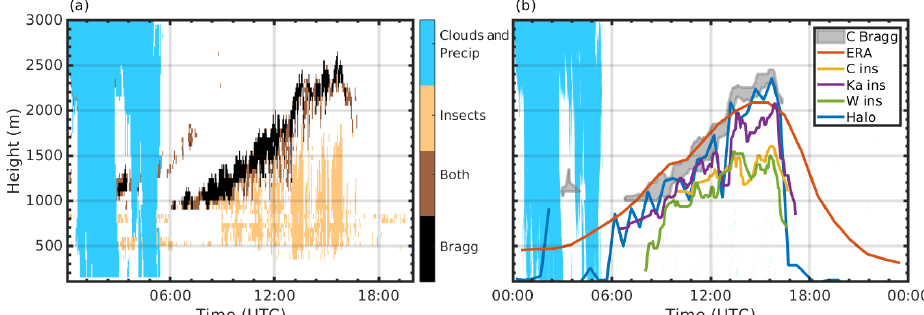
Figure 9. (a) The Bragg–insect classification mask derived from the C-band radar combined with a cloud/precipitation mask from the W-band radar for 18 May 2018. (b) Derived CBLH from all available radars compared with HALO Doppler lidar and